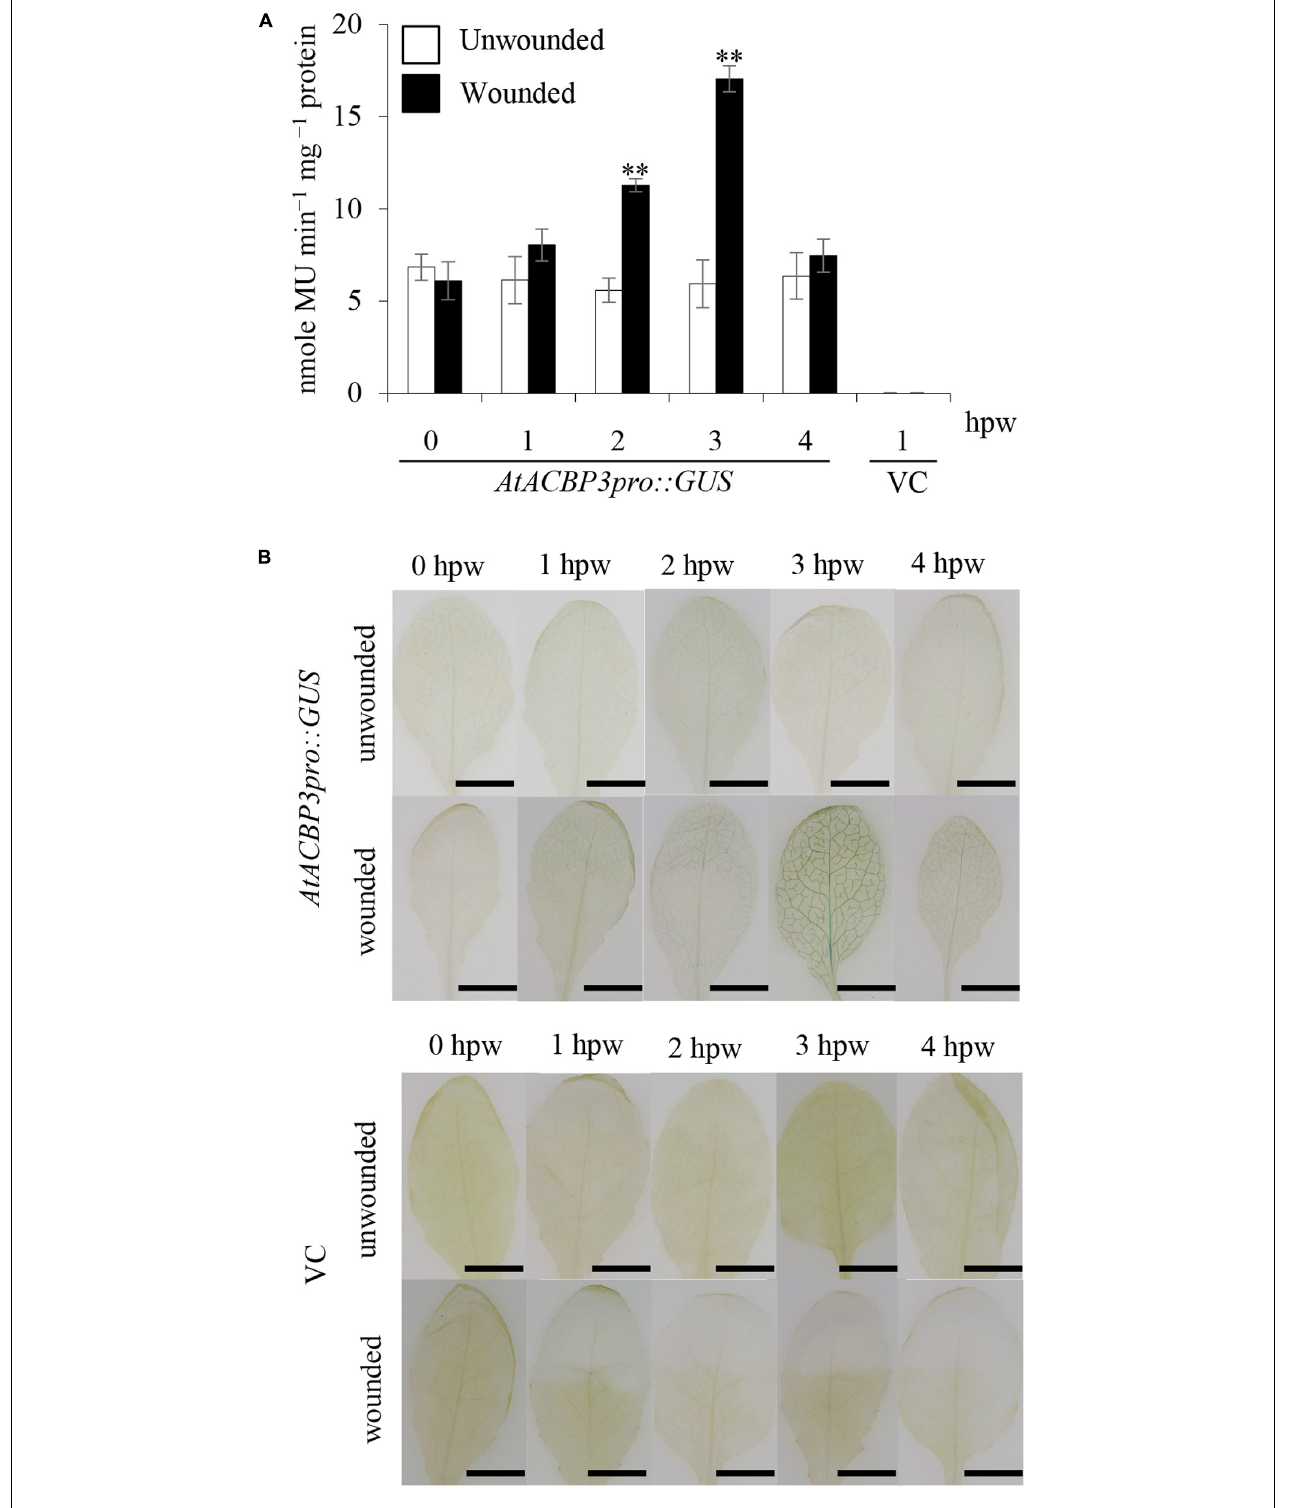
FIGURE 3 | GUS activity assays of transgenic Arabidopsis AtACBP3pro::GUS plants following wounding. (A) Four-week-old AtACBP3pro::GUS transgenic plants were wounded with a pair of forceps and harvested at 1, 2, 3, and 4 h post wounding (hpw) for quantitative GUS activity measurements. Vector (pBI101.3)-transformed plants were analysed at 1 hpw and served as a negative control, while unwounded AtACBP3pro::GUS plants were used as a baseline control.